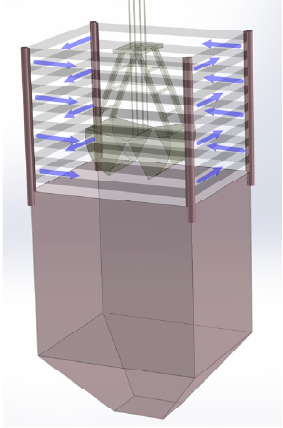
Figure 7. Schematic diagram of air curtain soft-sealing system.